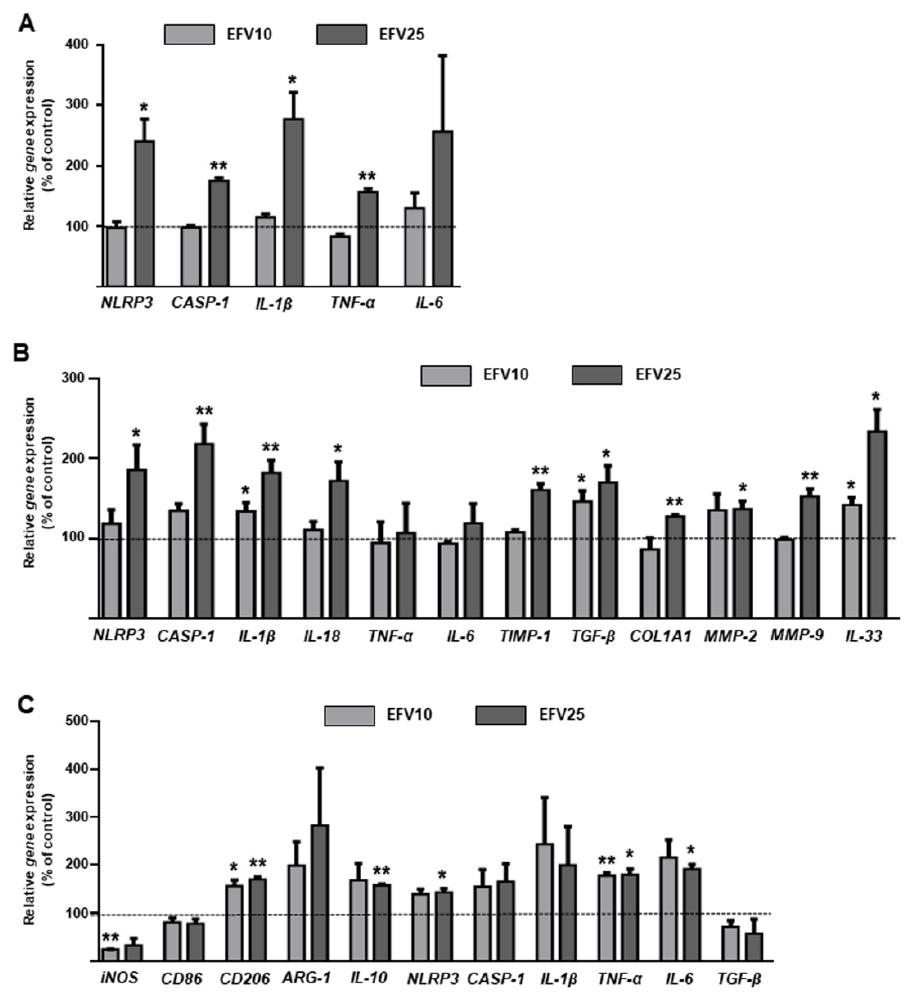
Figure 7. Effects of Efavirenz in human primary hepatocytes, hepatic stellate cells and Kupffer cells. Relative mRNA expression levels of inflammatory and fibrogenic genes in hepatocytes ( A ), hepatic stellate cells ( B ) and Kupffer cells ( C ) (RT-PCR). Data were normalized versus the housekeeping gene β -actin (n = 3). Data (mean ± SEM) were calculated as percentage of control (untreated cells) and analyzed by one-way ANOVA multiple comparison test followed by a Newman–Keuls test (* p < 0.05, ** p < 0.01 versus the respective solvent).